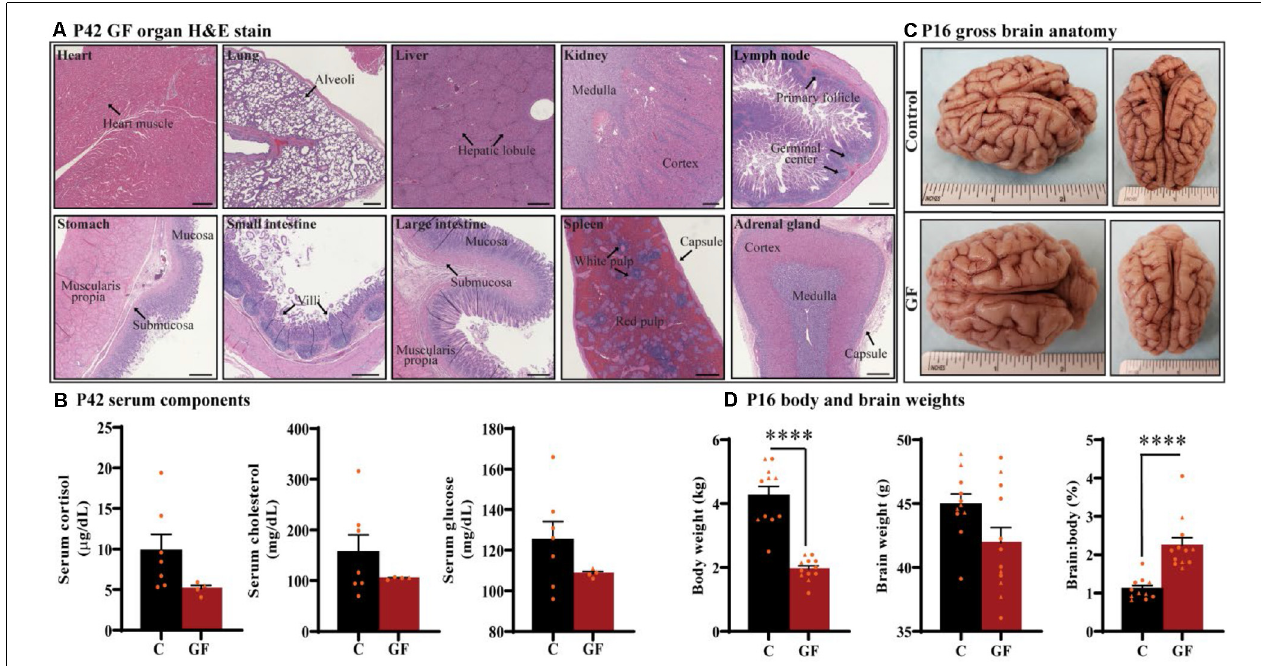
FIGURE 1 | General characterization of germ-free piglets. (A) H&E stains of germ-free (GF) organs at postnatal day P42. Scale bars, 500 µ m. (B) Quantification of cortisol, cholesterol, and glucose levels in the serum of GF and control (C) animals at P42. n = 4–7 animals/group. (C) Gross anatomy of a GF and a control animal at P16. (D) Quantification of the total body weight, brain weight, and percent brain to body weight ratio at P16. Individual male and female animals are marked by orange triangles and circles, respectively. n = 11–12 animals/group. Data are expressed as mean ± SEM. ∗∗∗∗ p < 0.0001, unpaired student’s t -test for body weight and brain weight, Mann-Whitney U test for percent brain to body weight